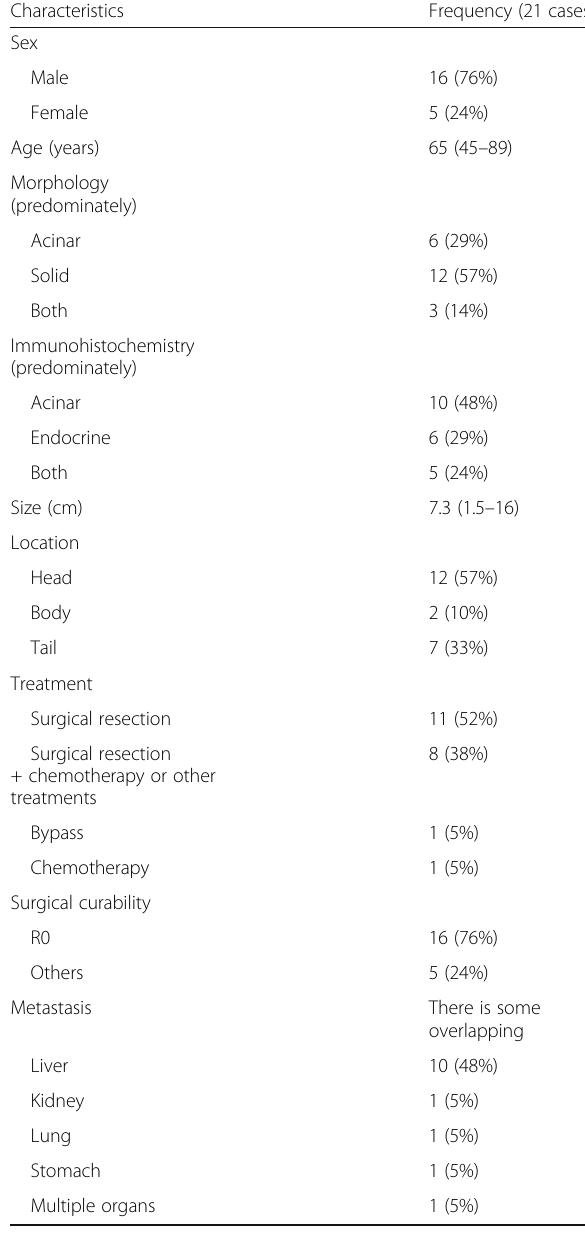
Table 1 Summarizing statistics of cases of mixed acinar-endocrine pancreatic carcinoma (21 cases including the present case)